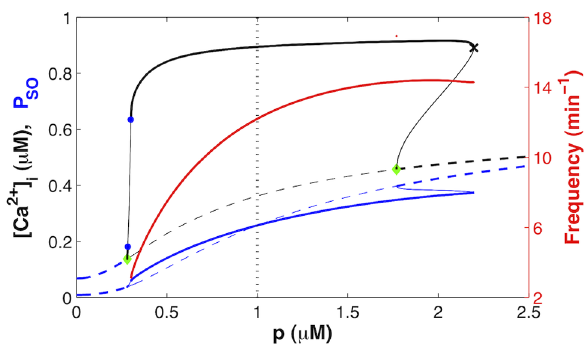
Figure 4. Ca 2 z dynamics as a function of agonist concentration. Dashed curves represent steady-states (constant Ca 2 z levels); solid curves, periodic solutions ( Ca 2 z oscillations). The maximum ½ Ca 2 z (cid:2) (black) and the maximum fraction of open SOCC (blue) during one solution period are plotted as ordinates. The red curve (right y-axis) shows the frequency of the Ca 2 z oscillations on the main stable segment (from the upper blue dot to the black cross), which fits the experimental range in human [2]. The stable solutions are represented as thick lines and unstable solutions as thin lines. The green diamonds represent Hopf bifurcations, the black cross, a saddle-node bifurcation, and the blue dots, period-doubling points. Period-doubled branches are not shown because they extend only over a tiny range of p values; moreover it is likely that the deterministic description of Ca 2 z oscillations fails at these low agonist concentrations (see Discussion). The vertical dotted line indicates the value of p used in Fig. 3 (Table 1).